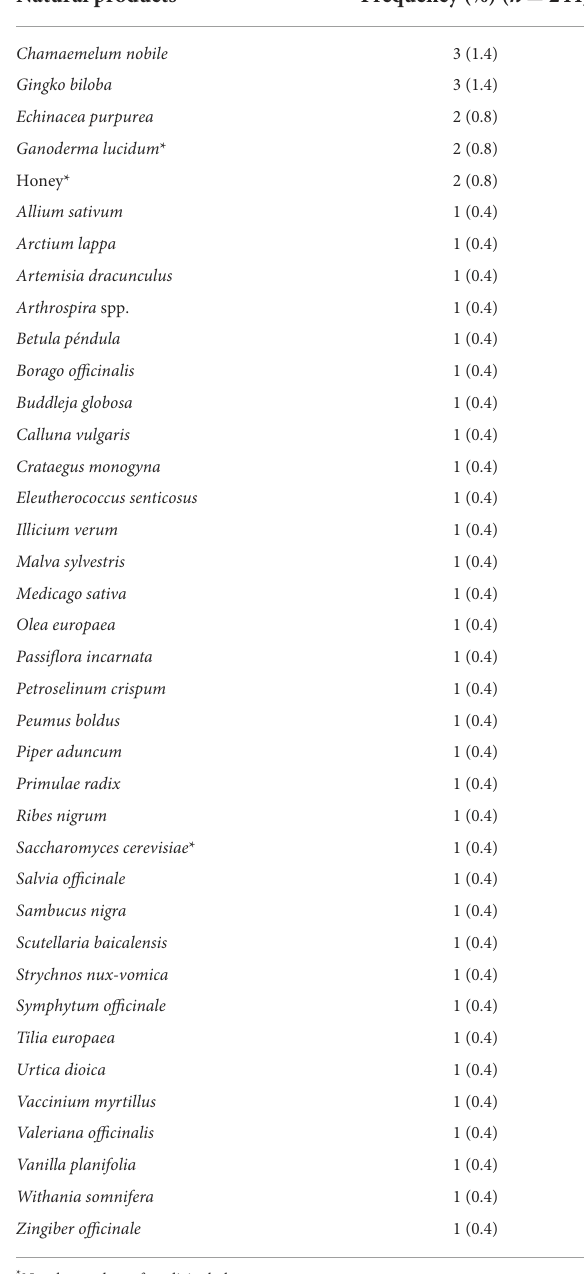
TABLE 3 Natural products commonly employed in disease treatment of the pets by Spanish small animal veterinarians. Natural products